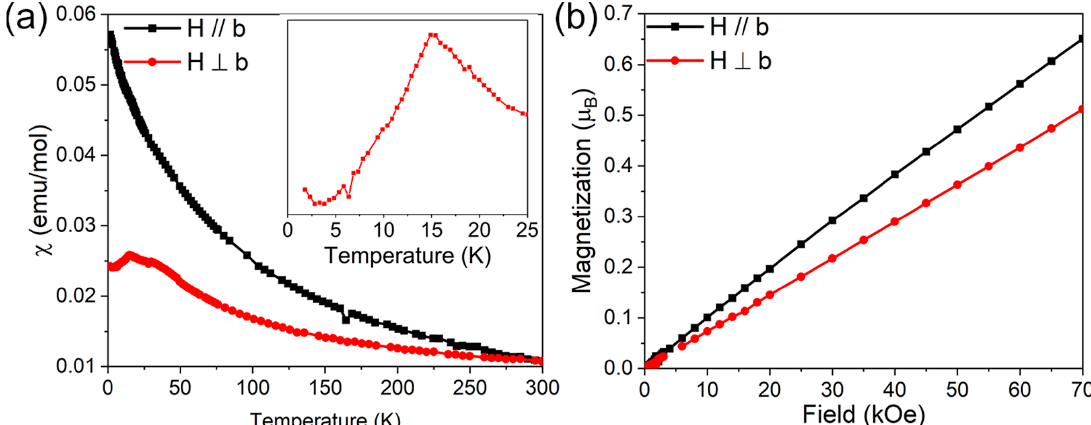
Figure 3. Temperature dependence of field-cooled (FC) magnetic susceptibility at 5 kOe ( a ) and field dependence of magnetization at 1.8 K ( b ) measured on a single crystal of BiMn 2 Se 4 with the magnetic field applied perpendicular and parallel to the long axis (the crystallographic b axis).